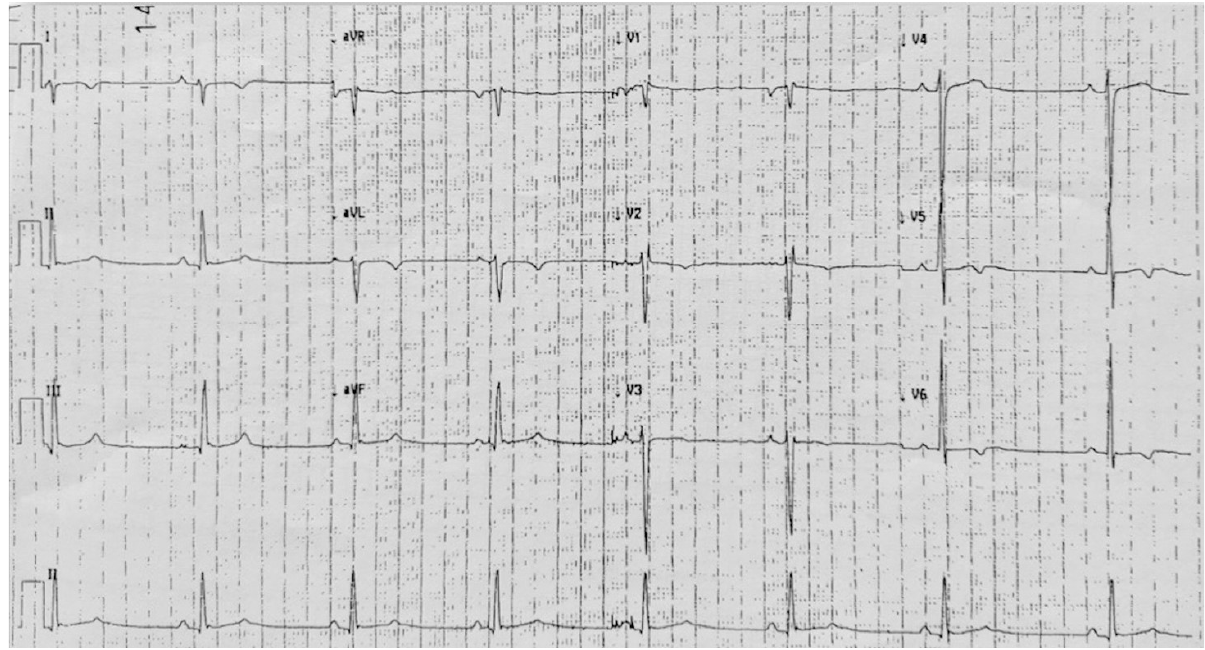
Figure 8. Resting ECG of 30-year-old ex-competitive male soccer player. Right axis deviation, traces of early ventricular repolarization in inferior leads, partial right bundle branch block, and negative T waves in lateral leads (D1-aVL and V5–V6). Negative P-wave terminal force in lead V1 is also present.